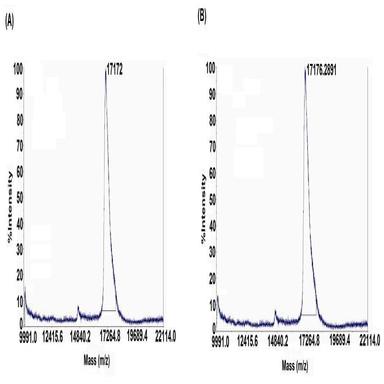
MALDI-TOF mass spectrometric study of Mb modified with MG for 21 and 28 days. MALDI-TOF mass spectra of Mb modified with MG for 21 days (A) and 28 days (B), respectively.